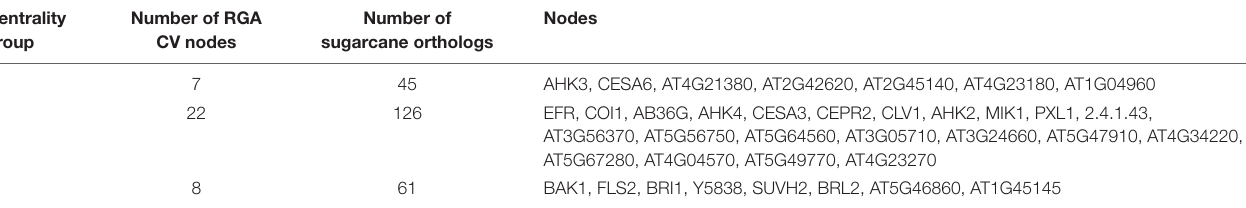
TABLE 2 | The number of RGA nodes identified as the CV in three centrality groups of the dual-layered network. Centrality Number of RGA Number of group CV nodes sugarcane orthologs